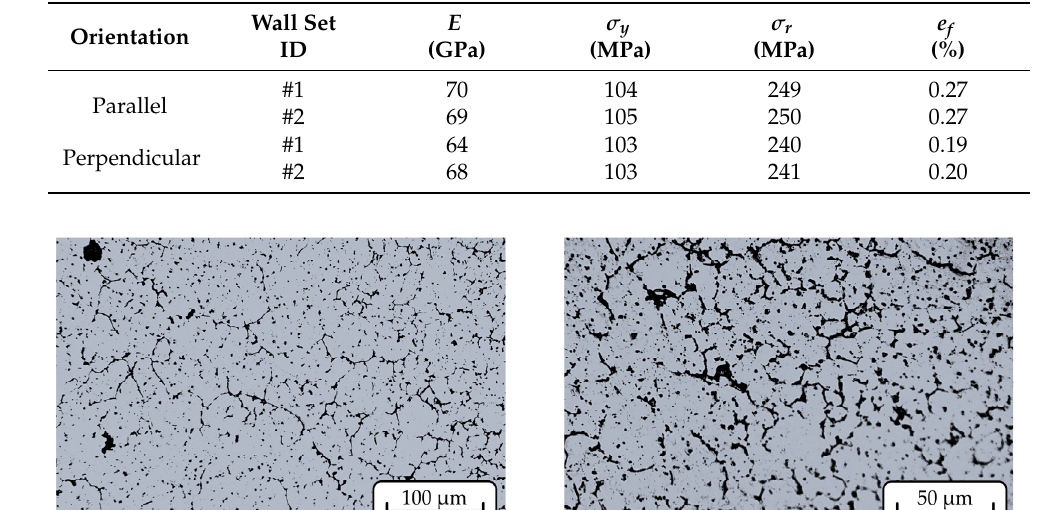
Figure 4. True stress–strain curves of deposited ER5356 aluminum wall sets #1 and #2 in parallel and perpendicular orientations to the building direction. Table 4. Mechanical properties of deposited ER5356 aluminum wall sets #1 and #2 in parallel and perpendicular orientations to the building direction.